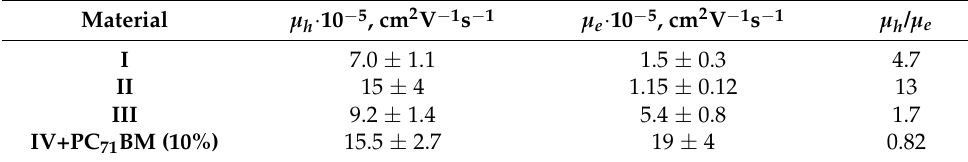
Table 1. Hole ( µ h ) and electron ( µ e ) mobilities.